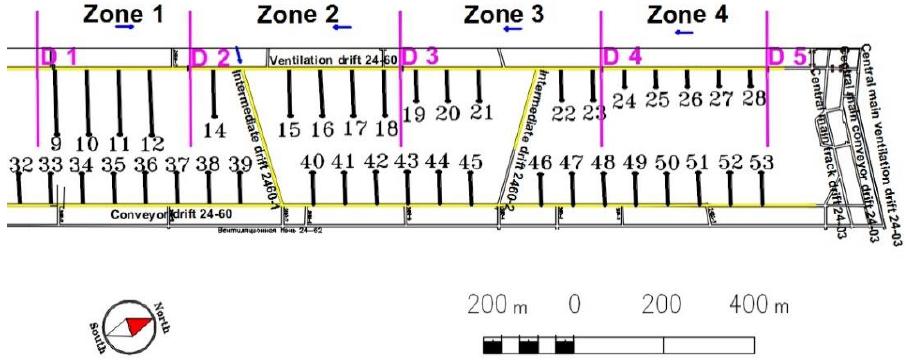
Figure 2. Location of UgHF wells of various lengths at extraction block 2460.